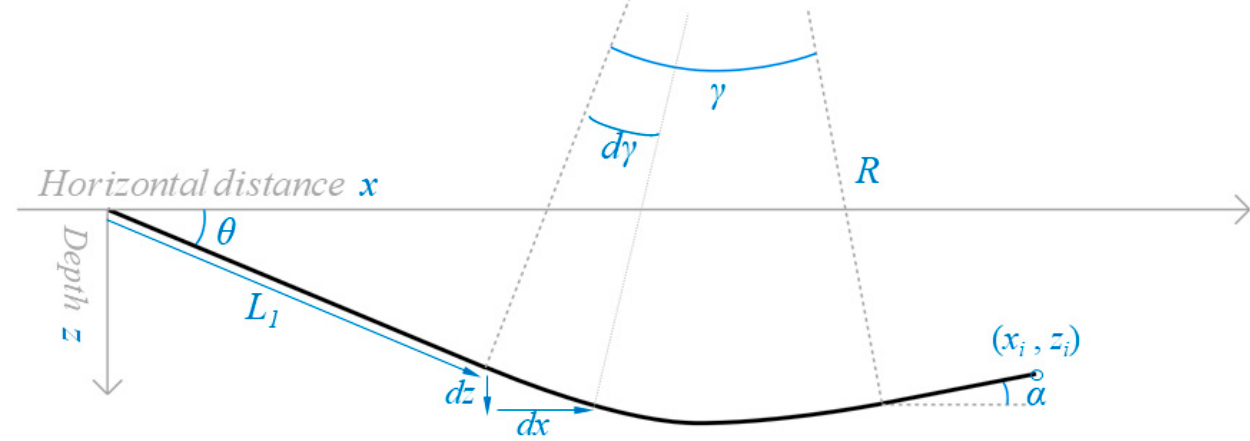
Figure 3. The geometric profile of alternating straight and curvilinear segments.